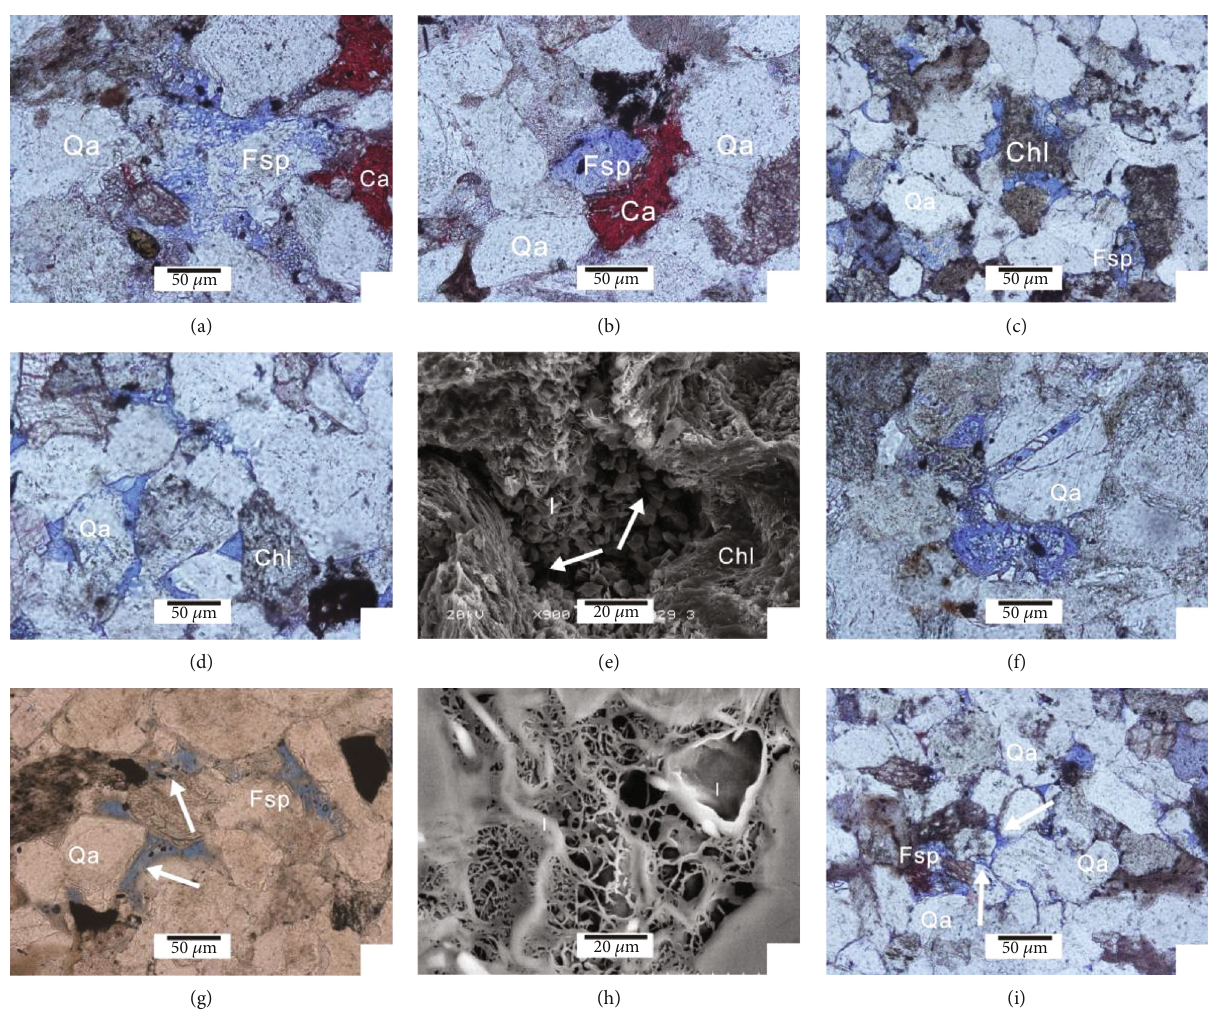
Figure 2: The characteristic of micropores in tight oil reservoir in the study area. (a) Intragranular dissolved pores within quartz (Qa) and feldspar (Fsp) at depth of 1294.8m of Well M2; (b) intragranular dissolved pores in feldspar (Fsp) and calcite cement (Ca) at depth of 2058.5m of Well S39; (c) intergranular dissolved pores in debris particles (Chl) and intragranular dissolved pores in feldspar (Fsp) at depth of 1667.5m of Well Y214; (d) residual intergranular pores at the edge of quartz (Qa) and debris particles (Chl) at depth of 1779.7m of Well M404; (e) intergranular honeycomb micropores of chlorite (chl) and illite (i) at depth of 1495.5m of Well P44; (f) The microfractures cut through quartz (Qa) at depth of 1606.9m of Well Y358; (g) curved throat among quartz (Qa) at depth of 1369.7m of Well X67; (h) the tube bundle channel within illite (i) at depth of 1151.5m of Well Z71; and (i) neck-constricted throat between quartz (Qa) and feldspar(Fsp) at depth of 1243 m of Well